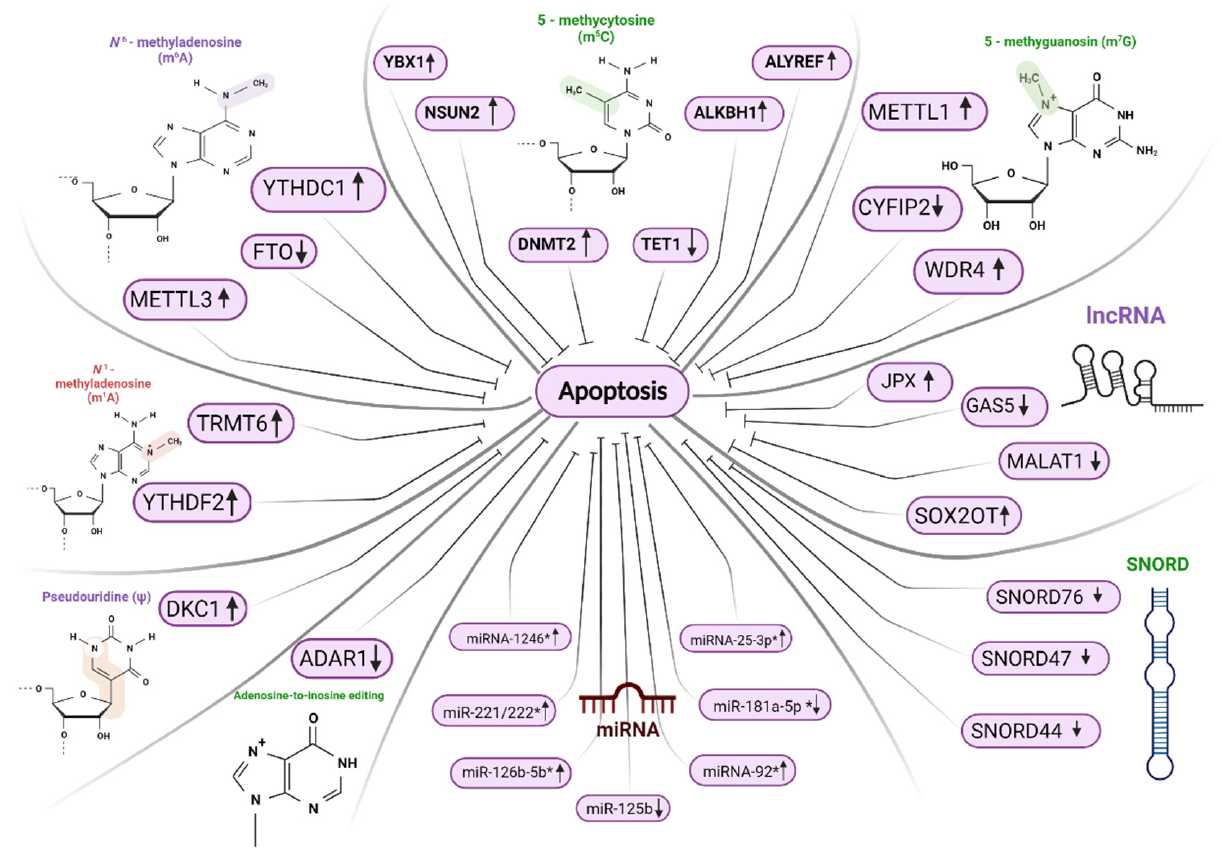
Figure 2. An overview of the modifications mentioned in the review and changes in the levels of key regulators that mediate apoptosis. ↑ means upregulation, ↓ downregulation. *—modified miRNAs or its pri-miRNAs.